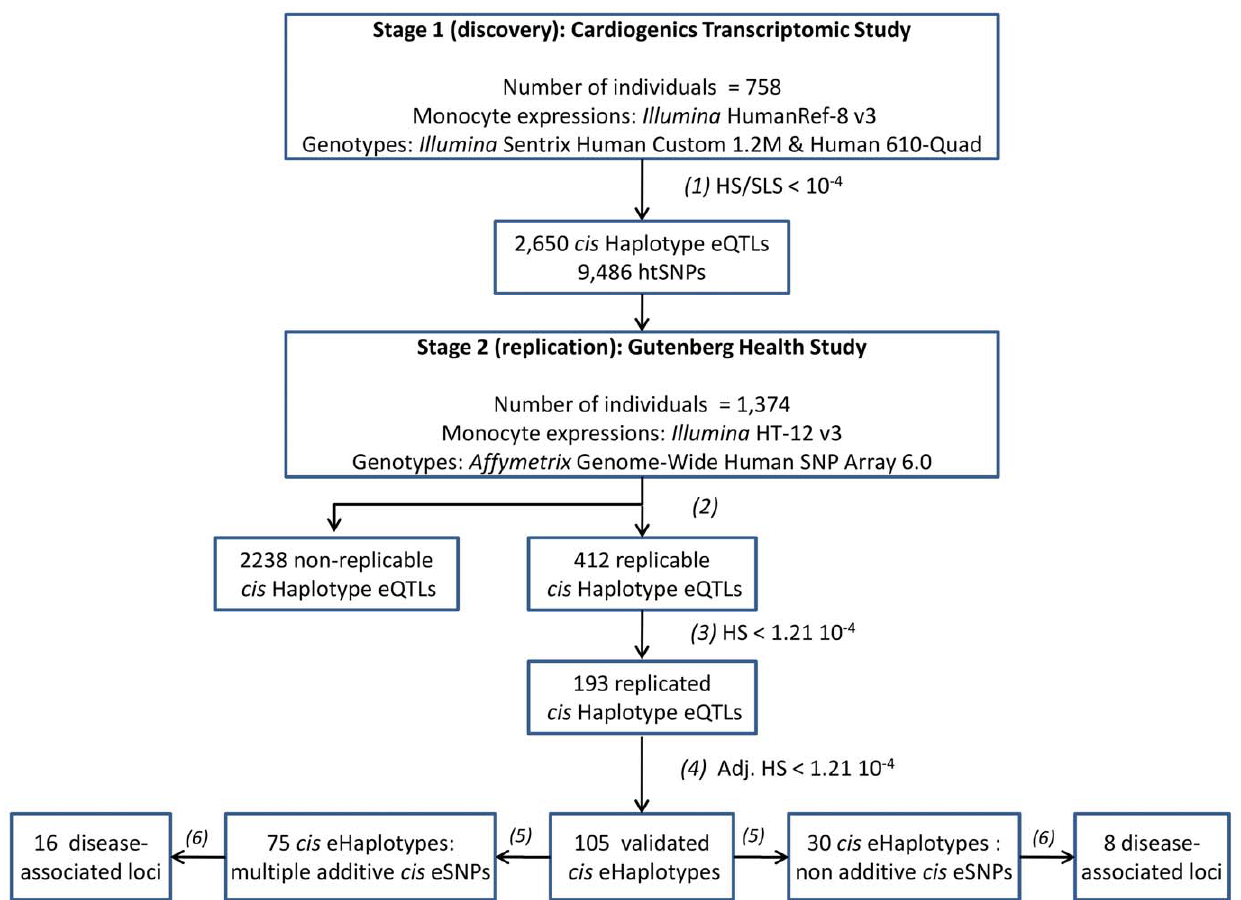
Figure 1. Main outlines of the research strategy for identifying cis haplotype effects. (1): Probes with best haplotype signal (HS) 104-fold smaller than the smallest single-locus signal (SLS) in the discovery study (CTS) were selected for replication in GHS. (2): Probes that had cis htSNPs available in GHS were considered as replicable. (3): Probes for which the global test of cis haplotypic association was significant at the Bonferroni threshold (1.21 10 2 4 ) in GHS and the pattern of cis haplotypic association was consistent between CTS and GHS (the same haplotypes with effects in the same direction) were considered as replicated. (4): Cis haplotypic associations were considered as validated when the haplotypic p-value was still significant at the Bonferroni threshold (1.21 10 2 4 ) after adjusting for the best (genotyped or imputed) SNP identified in single-locus association analysis in GHS. (5): Nested likelihood ratio tests and conditional haplotype analyses were used to check whether validated haplotype effects could be compatible with the additive effects of multiple SNPs (see Methods). (6): cis Haplotype eQTLs overlapping with disease-associated loci obtained from the Genome-Wide Association Studies catalog (Hindorff et al. 2009) [23]. htSNPs: haplotype tagging SNPs.